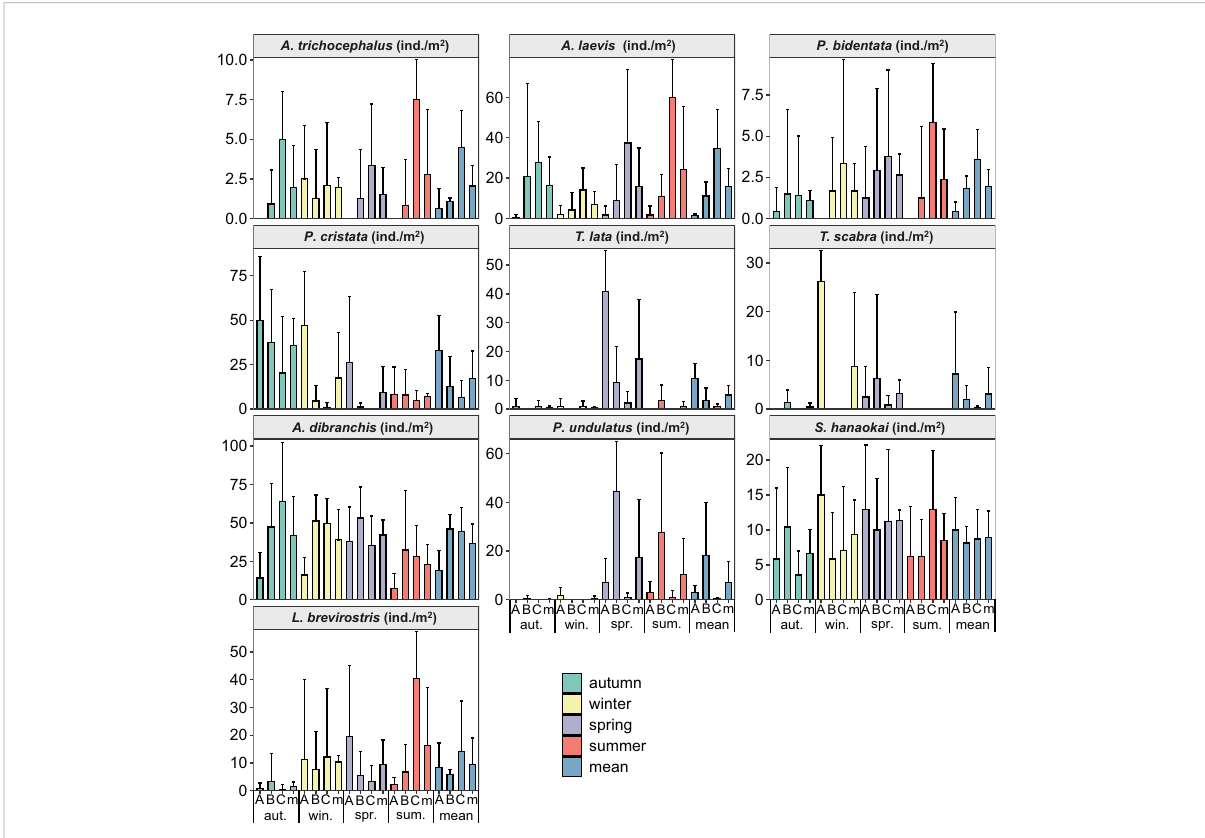
FIGURE 2 The density spatial and temporal distributions of ten species benthic macrofauna in subtidal zone near the Daya Bay Nuclear Power Plant. (A: represent the inner bay; B: represent the middle bay; C: represent the outside bay; m: represent the mean